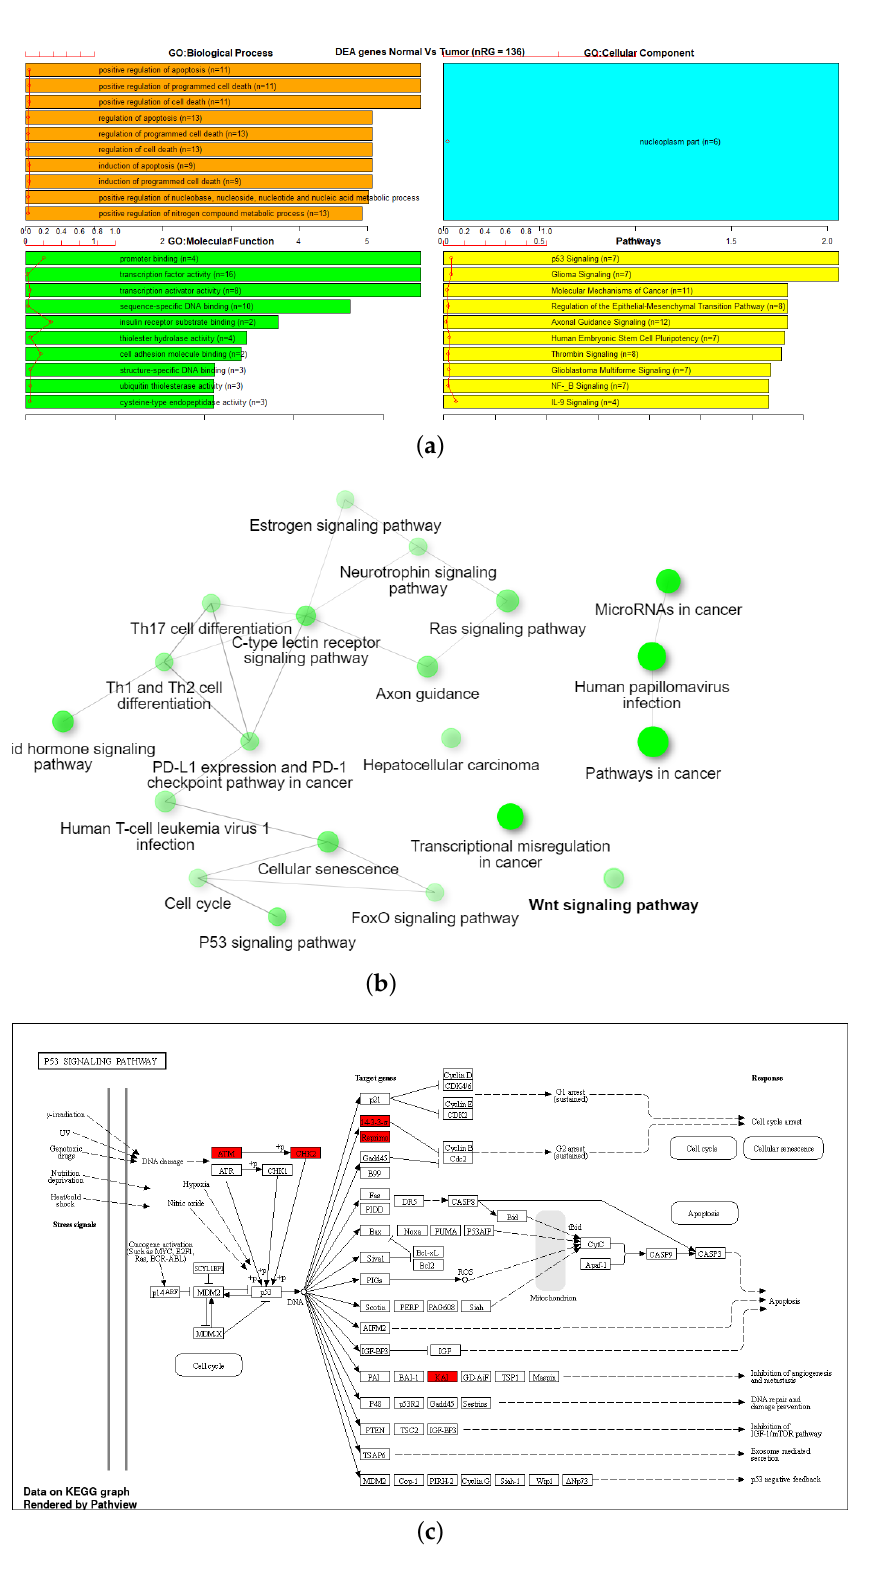
Figure 9. Gene Set Enrichment Analysis on Tumor suppressor/oncogene overlap subset of 450K with SMOTE, ( a ) TCGA EAanalysis where orange represents biological processes, cyan is a cellular component, green is molecular functions, and yellow represents pathways, ( b ) ShinyGO with network visualization of functional associations, and ( c ) ShinyGO enriched pathway visualization where red genes are in the gene set